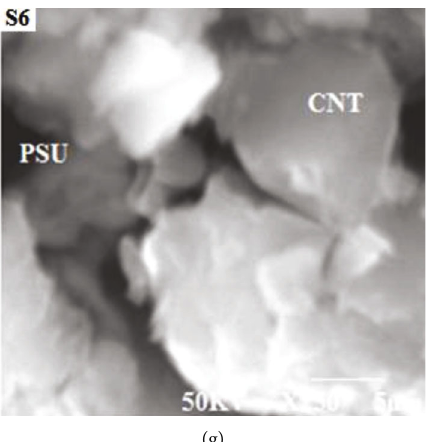
(g) Figure 2: (a) SEM micrograph of pure PSU. (b) SEM micrograph of PSU/2 wt% GNP. (c) SEM micrograph of PSU/4 wt% GNP. (d) SEM micrograph of PSU/6 wt% GNP. (e) SEM micrograph of PSU/3wt% CNT. (f) SEM micrograph of PSU/5 wt% CNT. (g) SEM micrograph of PSU/7 wt%